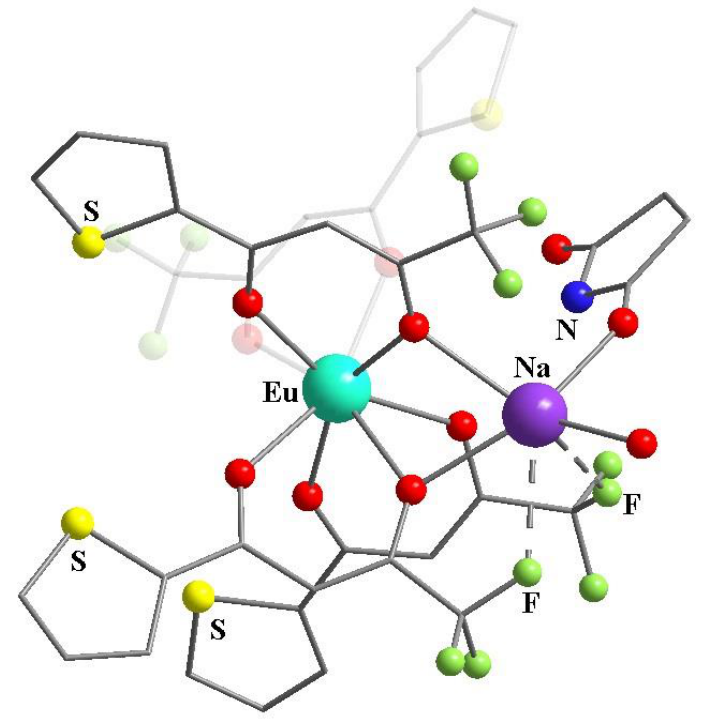
Figure 16. Molecular structure of 33 [85]. Hydrogen atoms have been omitted, some ligand groups are transparent for clarity. The cif has been retrieved from CCDC. CCDC number is 2013280. The functionalized lithium β -diketonate LiL 10 reacted with lanthanide(III) ions to form heterometallic compounds of various structures (Scheme 13) [62,86–89]. An extra functional group in the ligand saturated the metal ion coordination sphere with no additional coligands. Such homoleptic [Ln 2 L 6 ] complexes ( 34 ) were obtained in the case of Ln(III) ions with the largest radius. However, the reaction of lithium diketonate LiL 10 with most of the 4f metals led to the discrete β -diketonates 36 – 38 of three types depending on